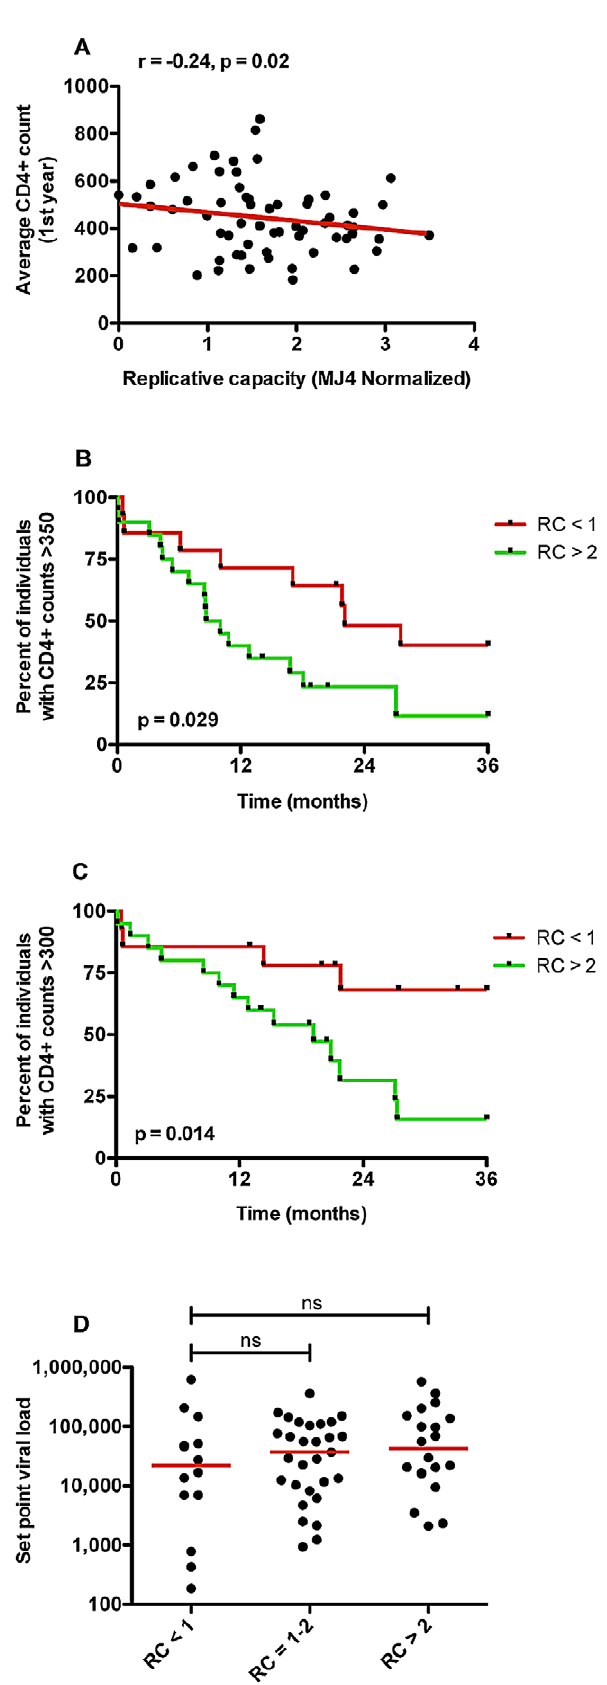
Figure 7. RC affects the rate of CD4 decline in a manner that may be independent of viral load. (A) In a subset of individuals for which longitudinal CD4 + counts were available for at least 1 year post infection (n=63), RC of Gag-MJ4 chimeras negatively correlated with the average CD4 + counts of linked recipients within the first year (Spearman rank correlation, r= 2 0.24, p=0.02). (B) Kaplan-Meier plots in which the endpoint was defined as the first CD4 + count below 350. Interval cut-off for endpoint was set to 36 months. The difference in median time to endpoint between those receiving viruses with RC , 1 (n=14) and RC . 2 (n=20) was 384 days (Log-rank test, p=0.029). (C) Kaplan-Meier plots in which the endpoint was defined as the first CD4 + count below 300. Interval cut-off for endpoint was set to 36 months. The difference in median time to endpoint between those receiving viruses with RC , 1 (n=14) and RC . 2 (n=20) was . 800 days (Log-rank test, p=0.014). (D) The difference in median VL between RC groups RC , 1, RC 1–2, and RC . 2 were not significantly different (Mann Whitney U test), consistent with the effect of RC on CD4 decline being independent of